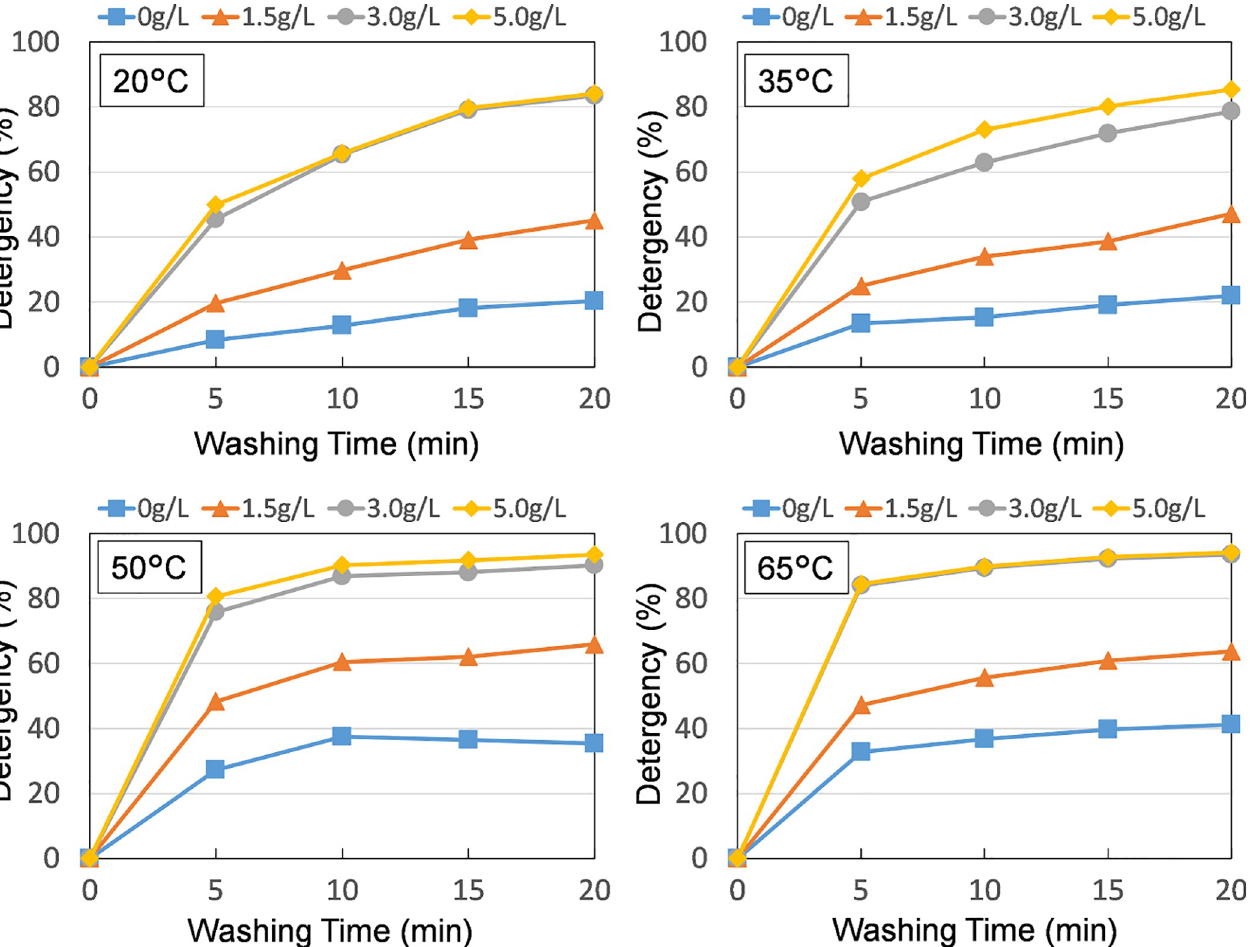
Fig 6. Time-dependent removal curves of hemoglobin soil obtained with respect to various temperature and SDS concentration levels: Soiled fabrics were washed using a tergotometer (80 rpm).